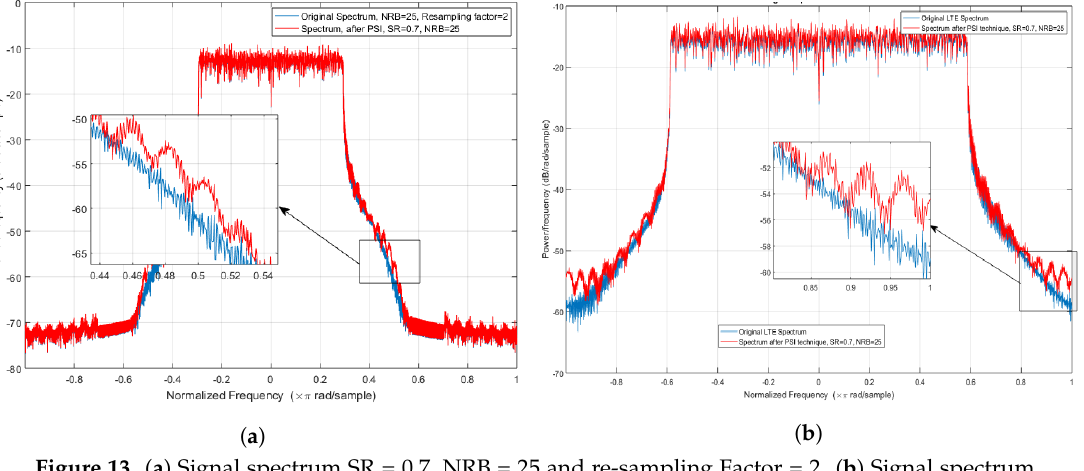
Figure 13. ( a ) Signal spectrum SR = 0.7, NRB = 25 and re-sampling Factor = 2. ( b ) Signal spectrum when SR = 0.7 and NRB = 25.